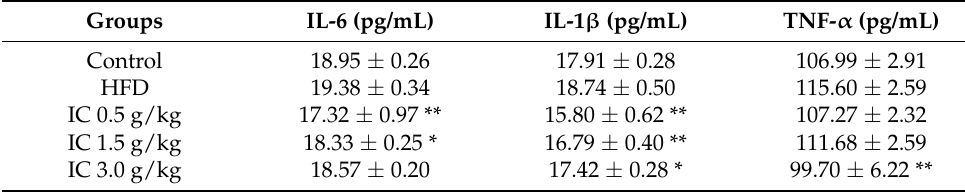
Table 2. Serum biochemical markers in each group (XS, n = 6).